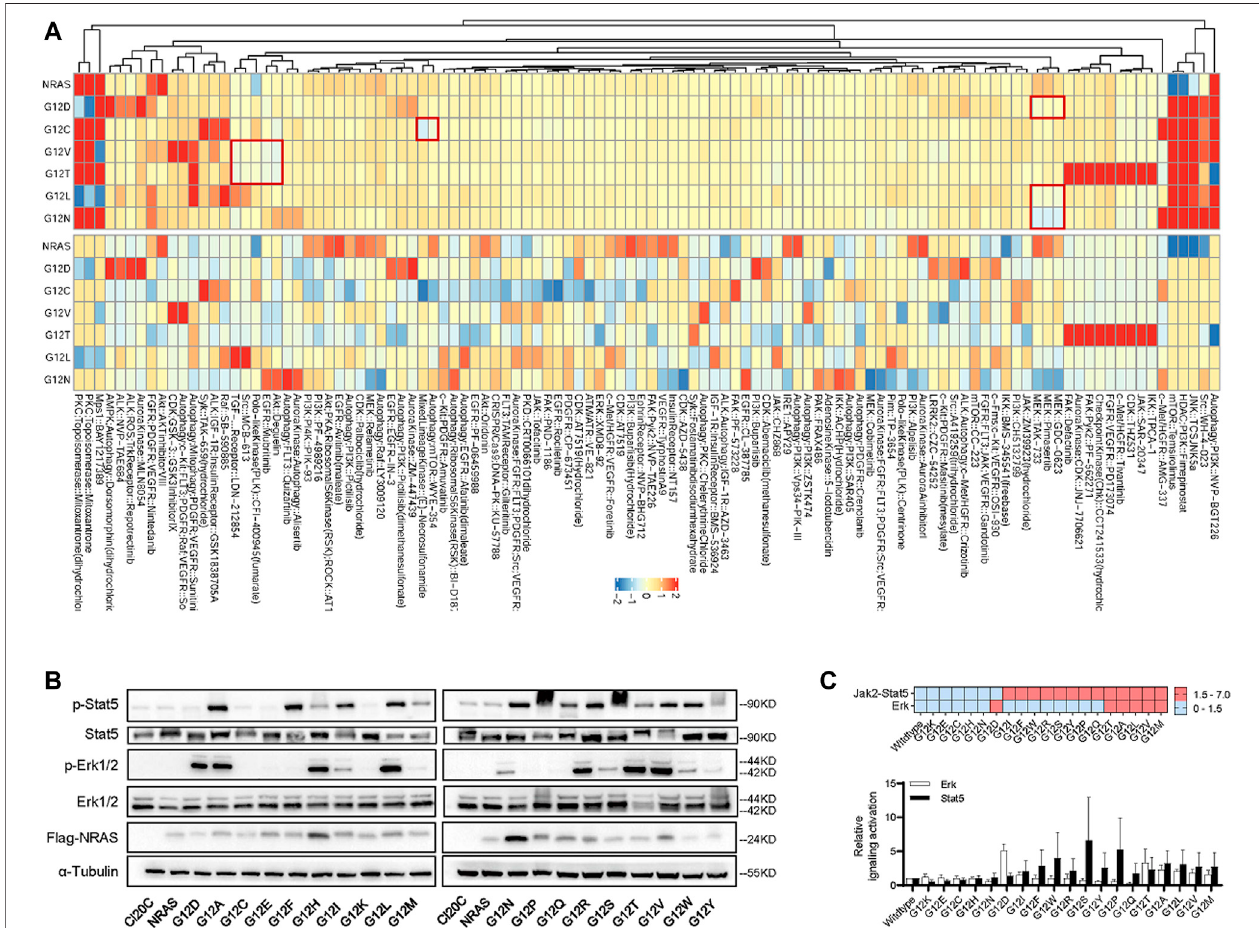
FIGURE 3 | The impact of NRAS G12 mutation on drug sensitivity. (A) Normalized heatmap of HDS results (log10 of IC50 concentration) among Ba/F3 cells with different NRAS mutation. All these experiments were performed in triplicate and independently repeated three times. (B) Western blotting assay of Ba/F3 cells transduced with NRAS G12 mutants. (C) Heatmap (upper panel) and grey intensity plot (lower panel) to Erk and Jak2-Stat5 signaling pathways activation in Ba/F3 transduced with NRAS G12 mutants.